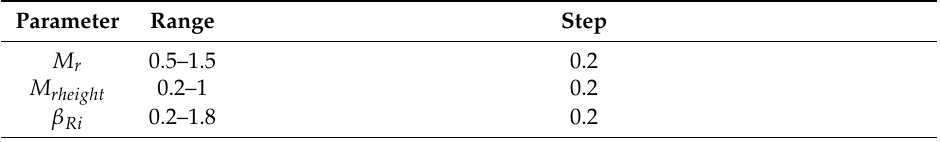
Table 9. FE simulation information of the rotor parameters.